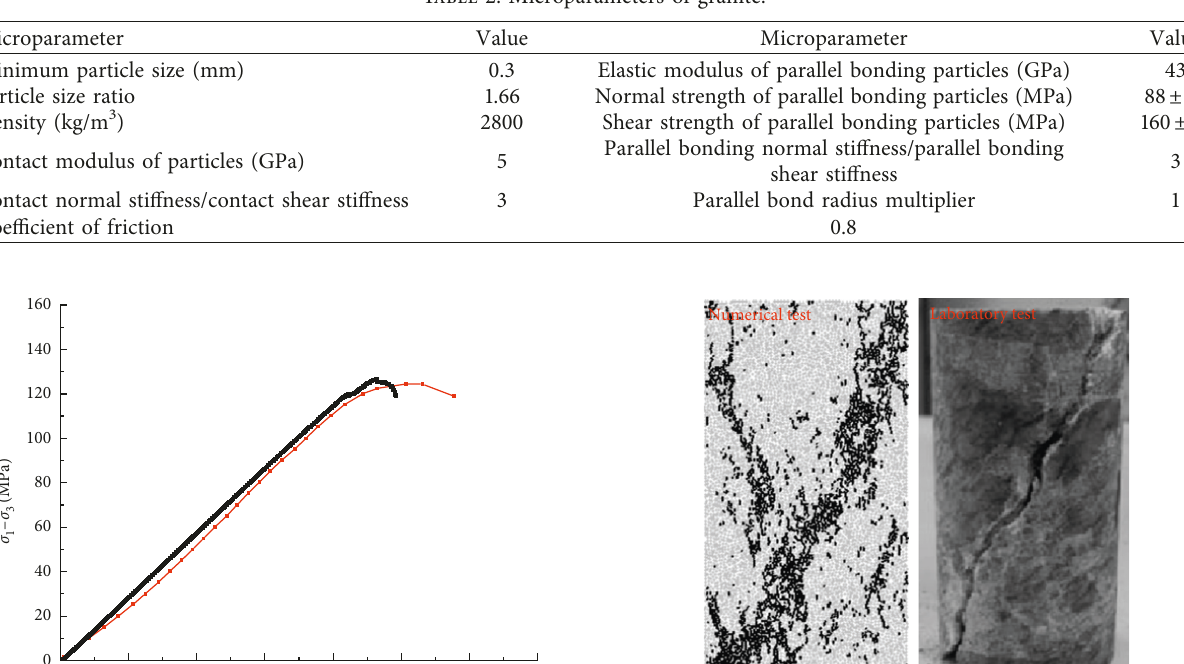
Table 2: Microparameters of granite.